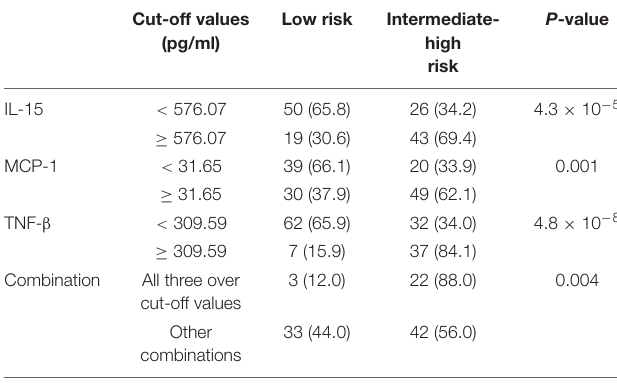
TABLE 2 | The growth risk of UIA patients with serum cytokines over or below the cut-off value. Cut-off values Low (pg/ml)